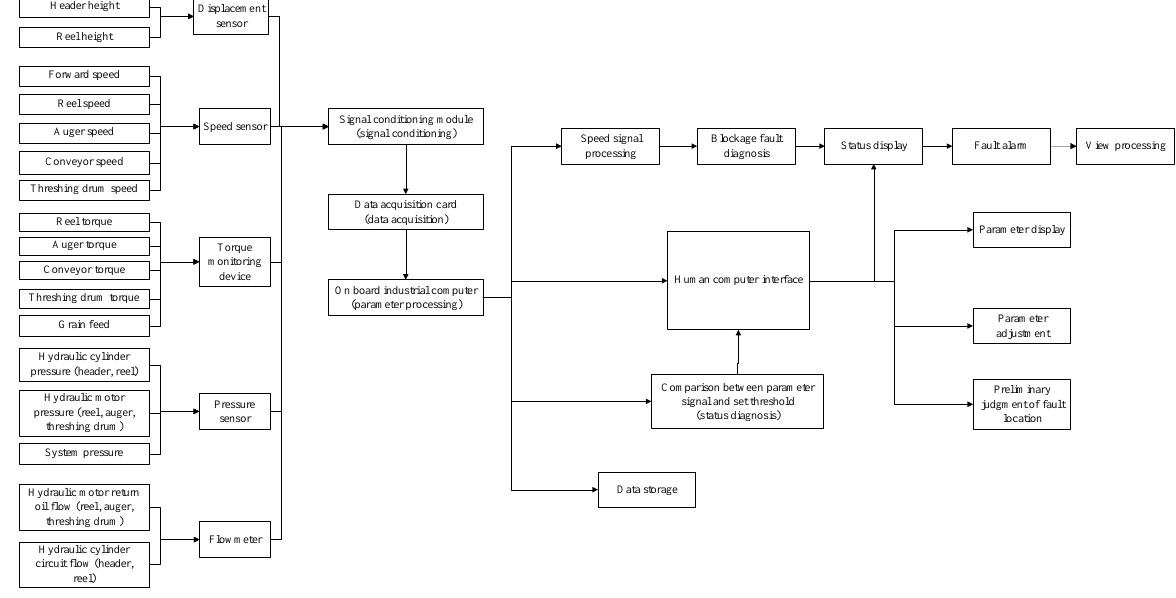
Figure 4. The overall design of hydraulic monitoring system for a combine harvester.